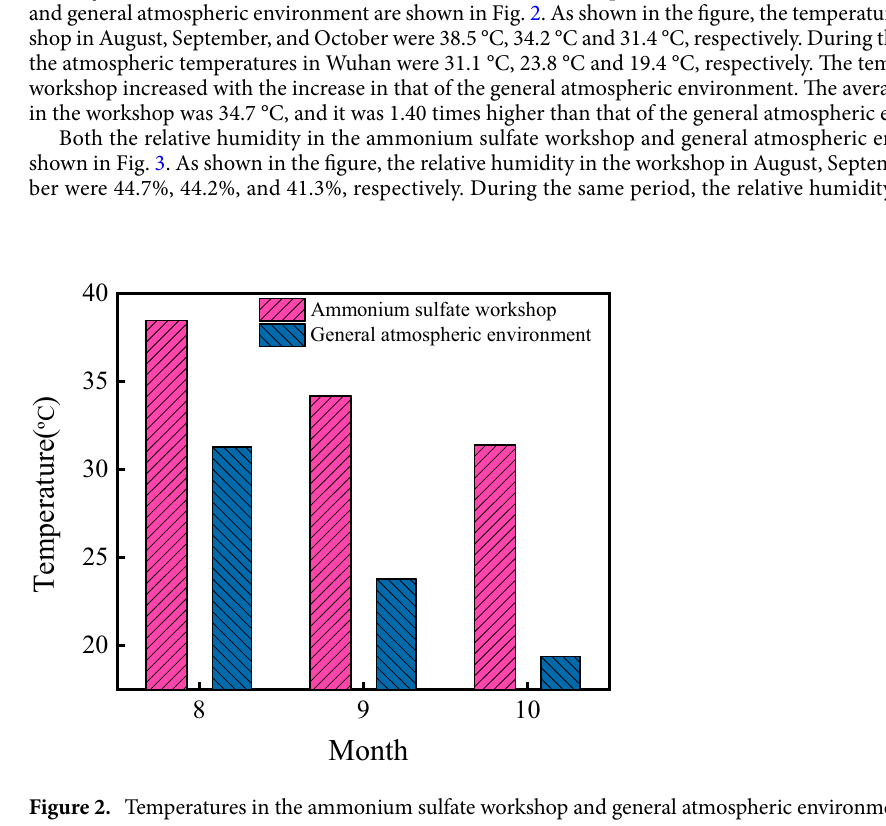
Figure 2. Temperatures in the ammonium sulfate workshop and general atmospheric